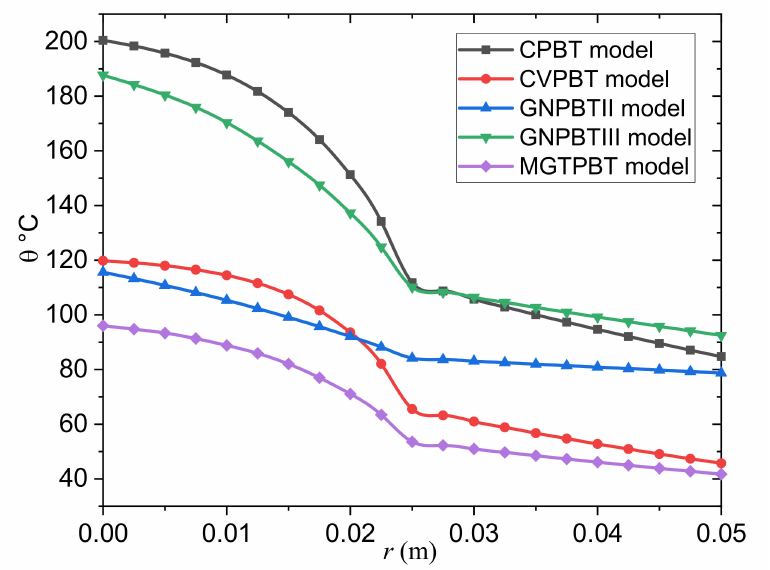
Figure 4. Temperature variation in the tumor and normal tissues for different models of the PBT